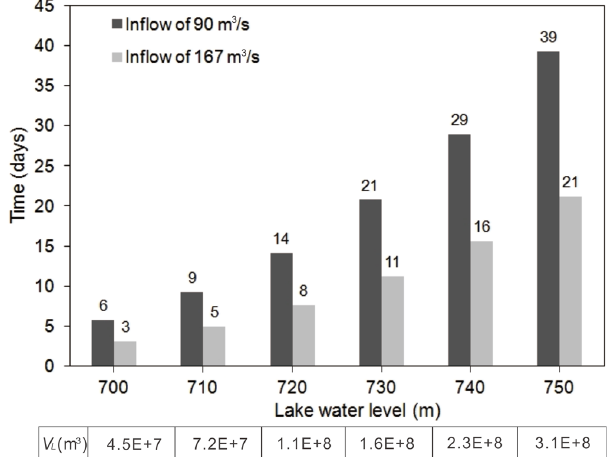
Fig. 16. Time needed for the barrier lake rising to a certain level and the lake volume ( V L )